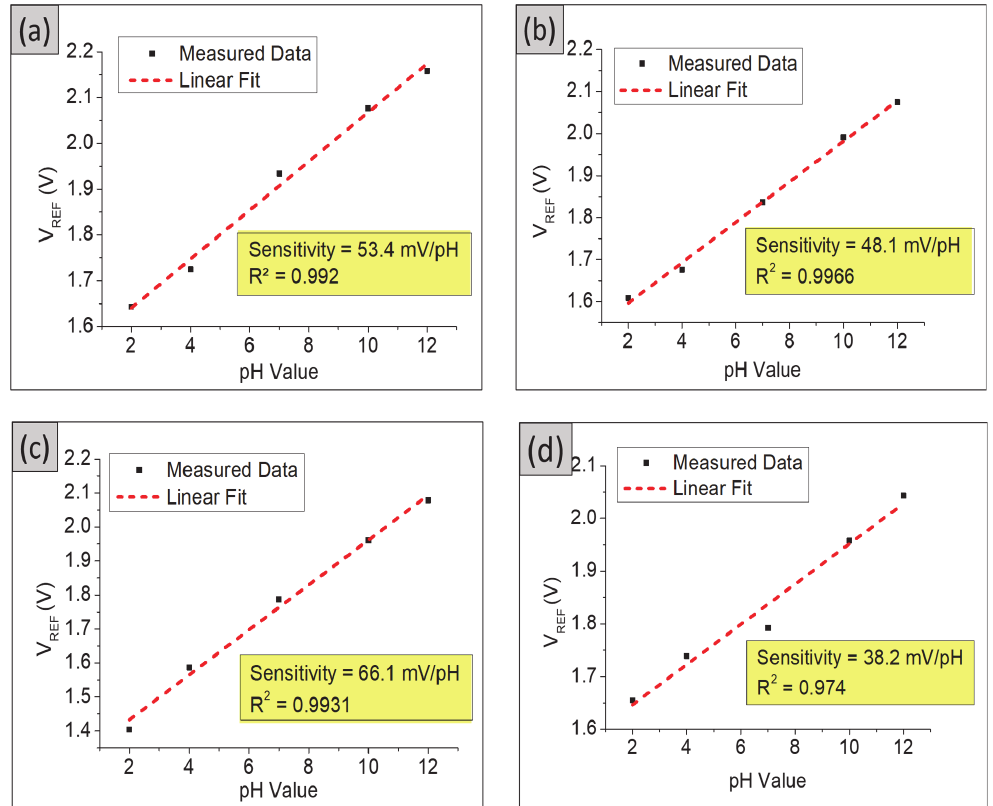
Figure 4. pH sensitivity in linear region for ( a ) TiO 2 thin film, ( b ) TiO 2 –PANI bilayer composite thin film, ( c ) TiO 2 –PANI composite thin film, and ( d ) ITO substrate.